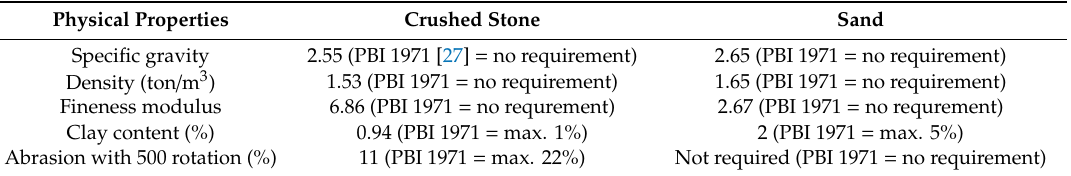
Table 1. Physical properties of sand and crushed stone.